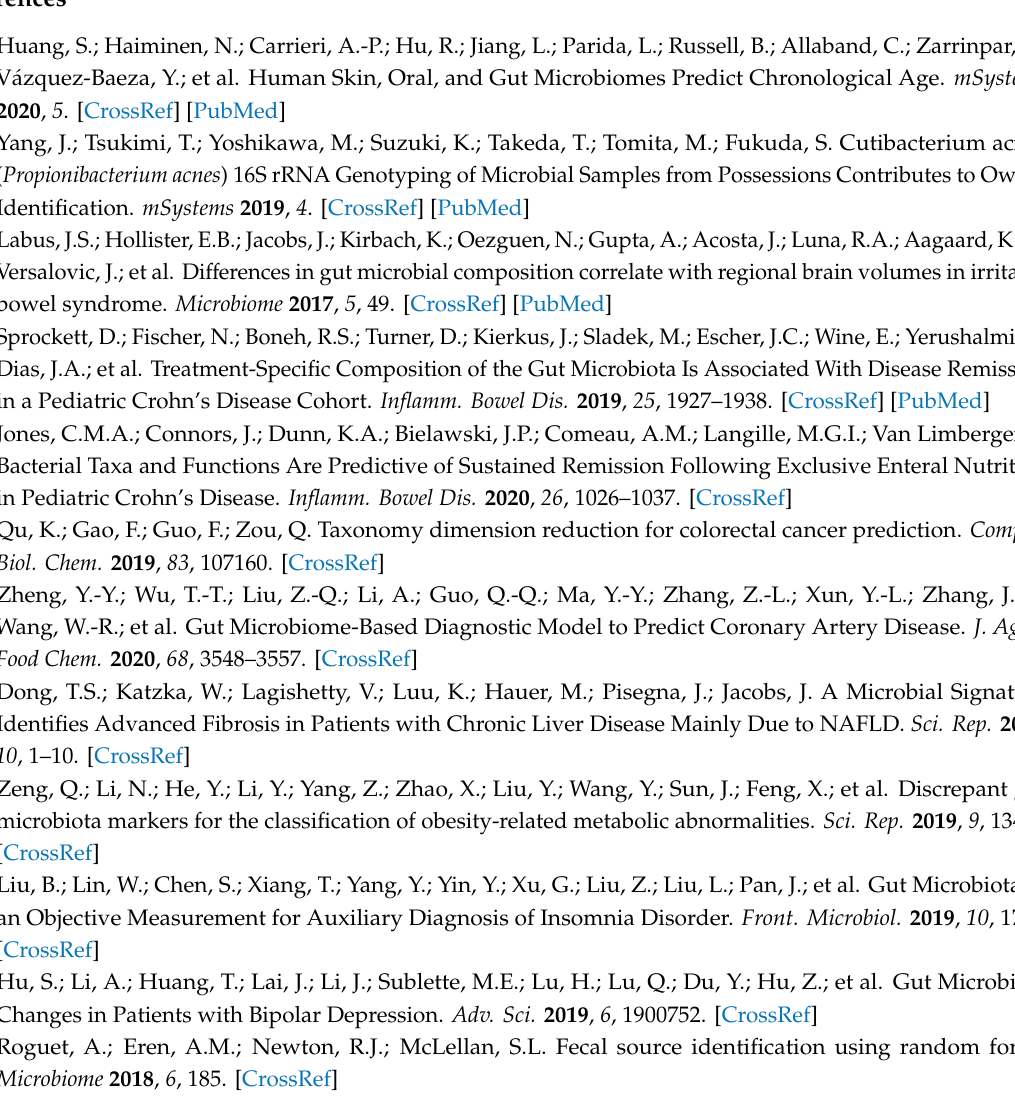
Figure S4: Top families and genera important for human / pet host discrimination as suggested by random forest models; Figure S5: The dependency of accuracy on test human projects from the number of human projects used in the training set; Table S1: Taxonomic feature abundances in the data, features with low abundance; Table S2: The accession numbers of the specific samples used in the training dataset; Table S3: Di ff erentially abundant taxa, results of Mann-Whitney test; Table S4: Summary of models performance; Table S5: The accuracy of the genus models on additional datasets; Table S6: Estimated accuracy, precision, recall, and f1 score of the genus models; Text S1: Parameters selection of random forest